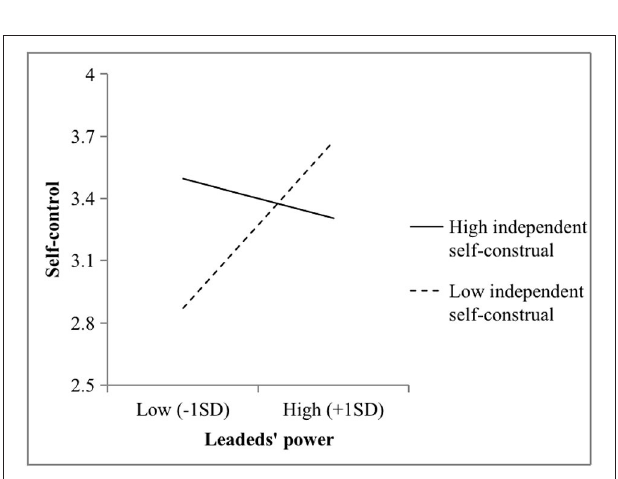
FIGURE 3 | Two-way interaction effect between the power and independent self-construals of the leaders on self-control in Study